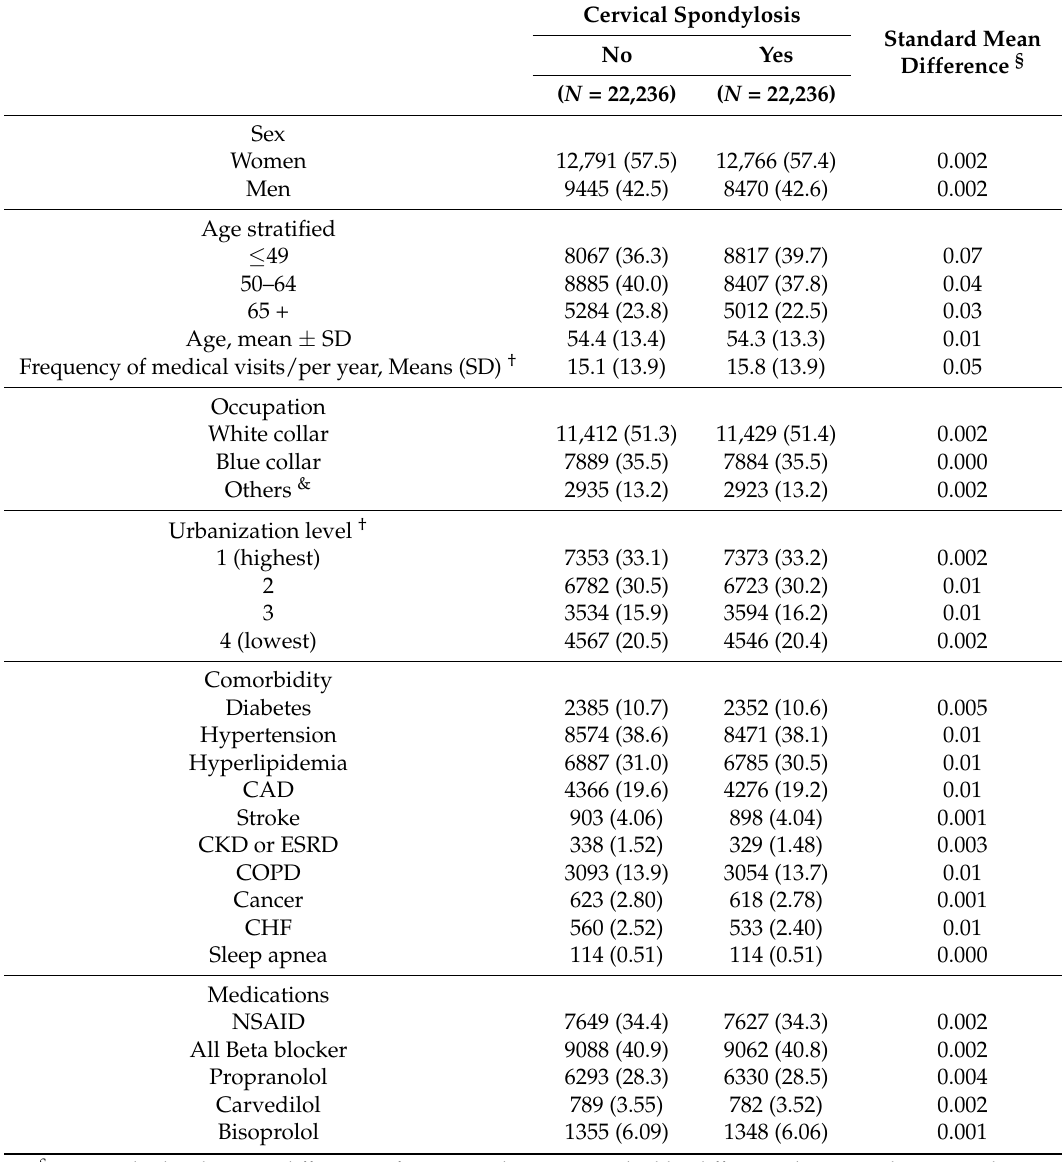
Table 1. Demographic characteristics and comorbidities of propensity-score matched patients with and without cervical